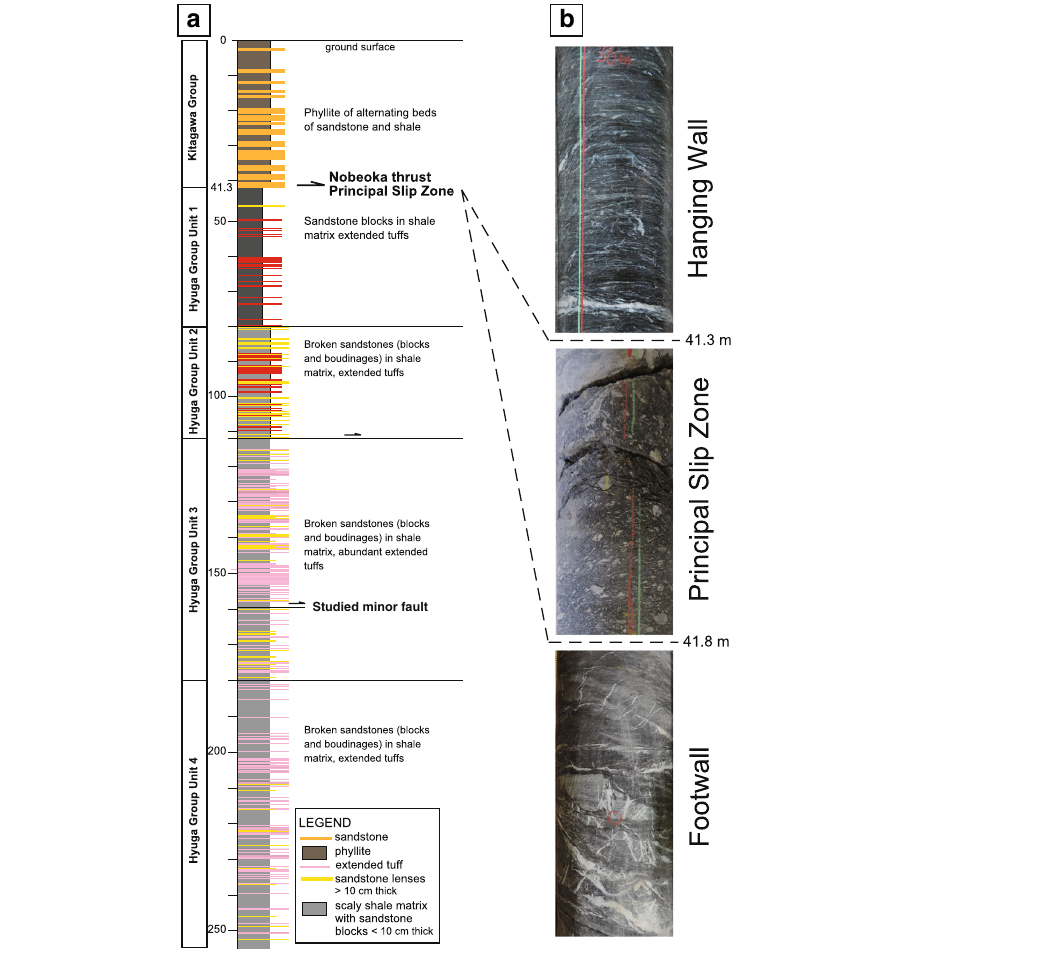
Fig. 2 Borehole core lithology and core photos. a Integrated columnar section showing core lithology (modified from Fukuchi et al. 2014). b Borehole core photos representing the hanging wall, principal slip zone and footwall. Depth of the core photos of hanging wall, principal slip zone and